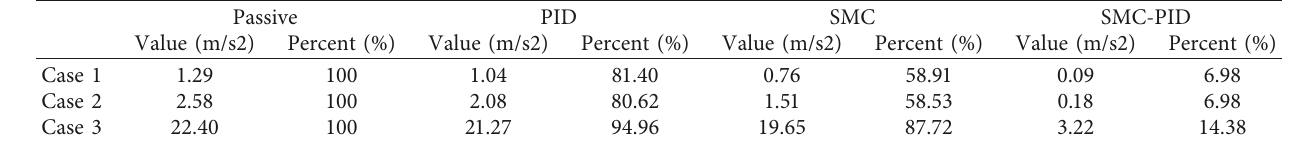
Table 4: The maximum acceleration of the sprung mass.